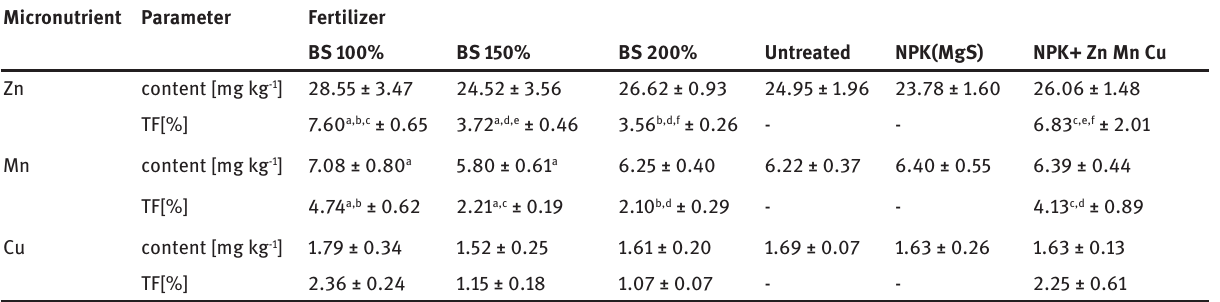
Table 5: Effect of fertilization on the micronutrients content and TF for maize grains. Micronutrient